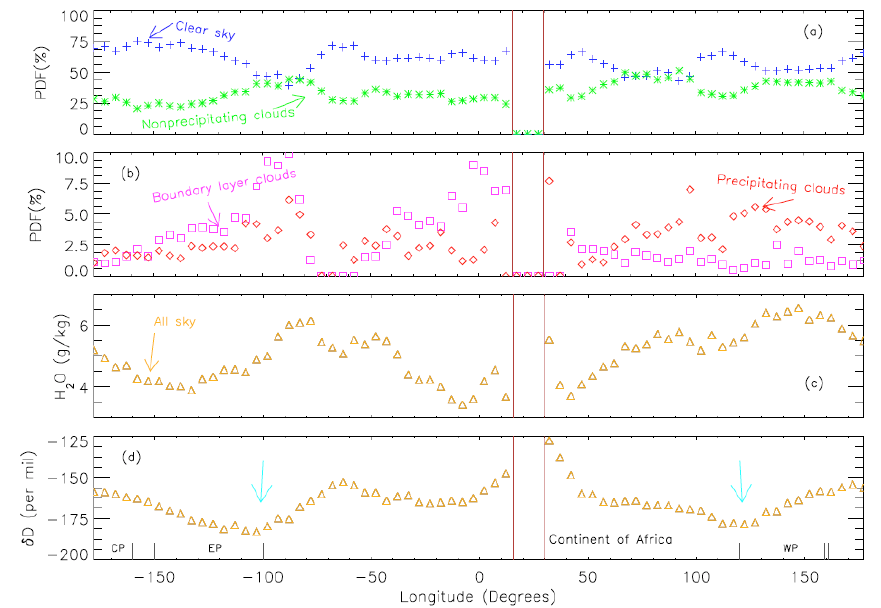
Fig. 4. Longitudinal distributions of cloud ( a and b ), water vapor (c) and its isotope (d) over tropical ocean. There is no tropical oceanic data point between 15 ◦ to 35 ◦ . (a) Clear sky (blue cross) and nonprecipitating clouds (green asterisk). (b) Boundary layer clouds (cyan square) and precipitating clouds (red diamond). (c) Water vapor (g/kg) for all sky conditions (d) Water vapor isotope (‰). The two magenta arrows indicate isotopically depleted regions. The cloud types were classified based on the ISCCP. Longitudinal mean ( − 15 ◦ < Latitude < 15 ◦ ) were binned at 5 ◦ longitudes.